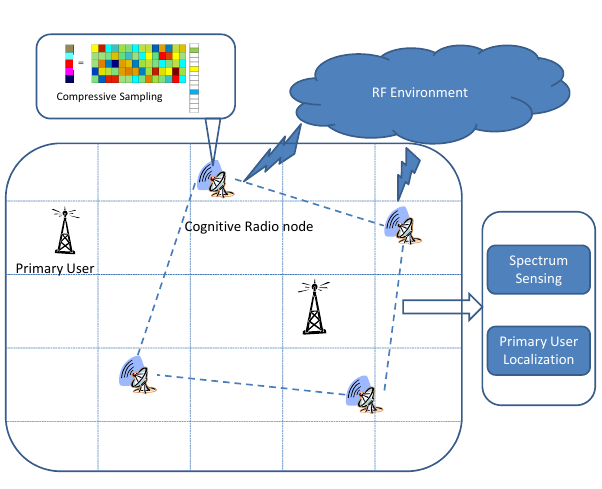
Figure 1. An illustration of system